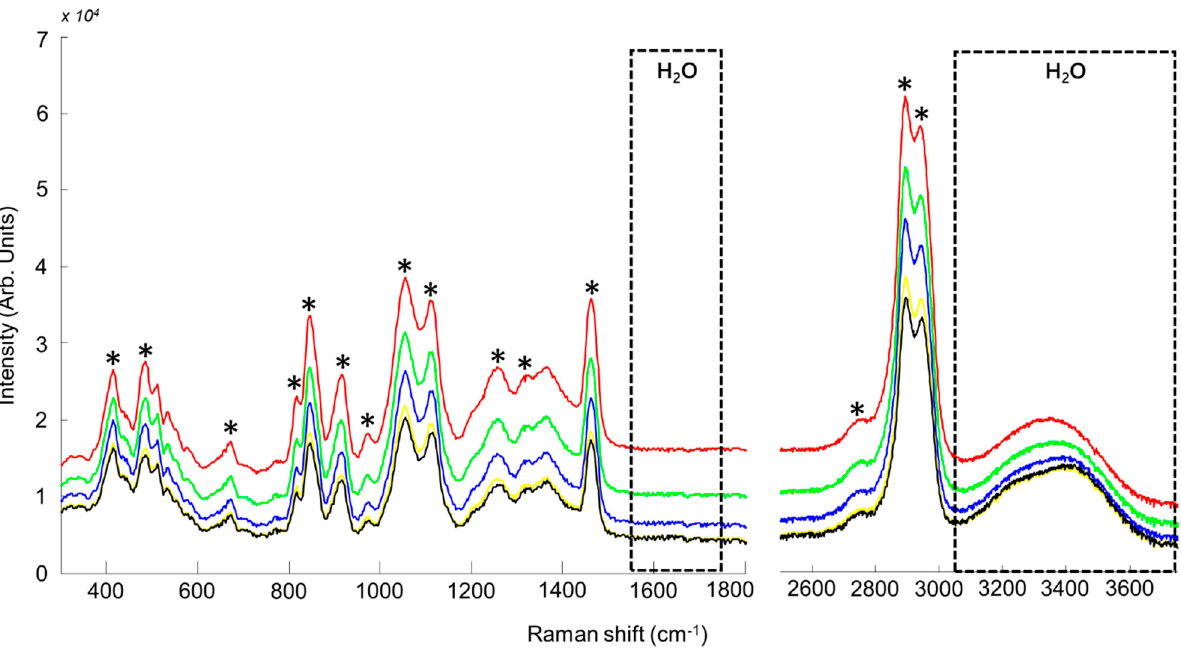
Figure 4. Mean Raman for GG samples (concentrations for water are respectively 0% (red), 9.094% (green), 16.67% (blue), 23.079% (yellow), and 28.57% (black). * Indicates bands corresponding to glycerol. The dotted boxes indicate the positions of H 2 O features.